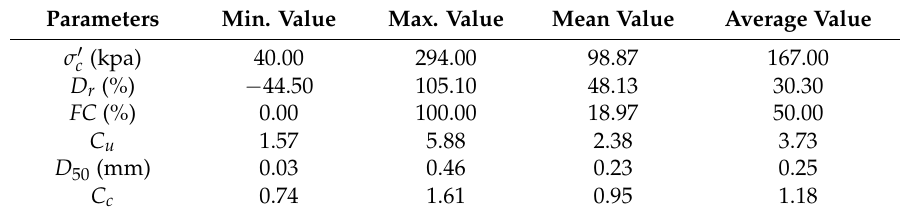
Table 1. Characteristics of complete input parameters used for the first ANN model and RSM equation.